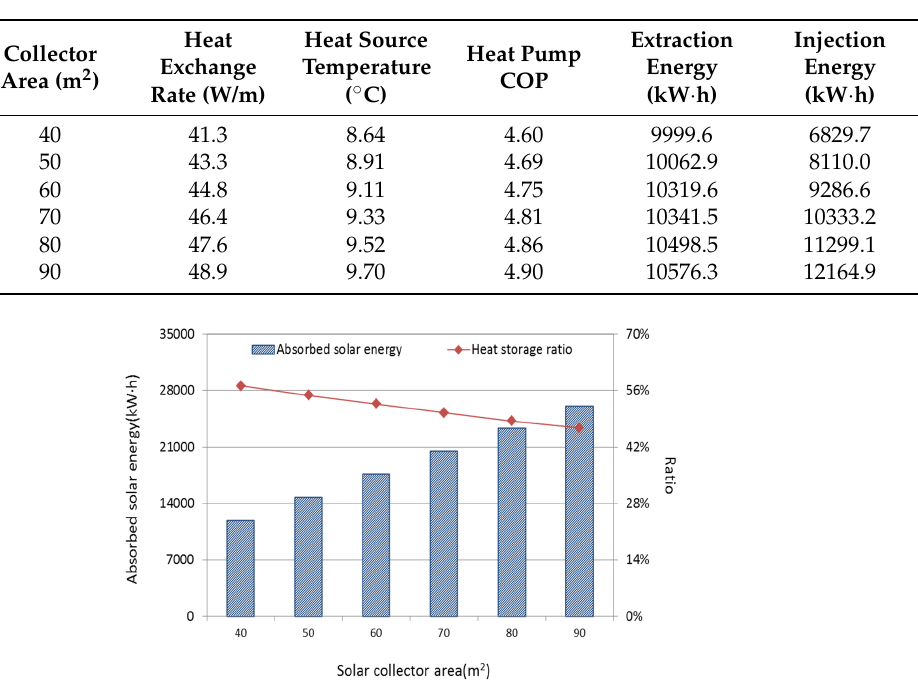
Table 3. Simulation results with different collector area.